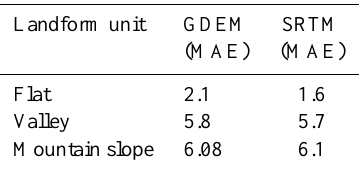
Figure 12. Result of a denoising algorithm (Sun et al., 2007) on the fused